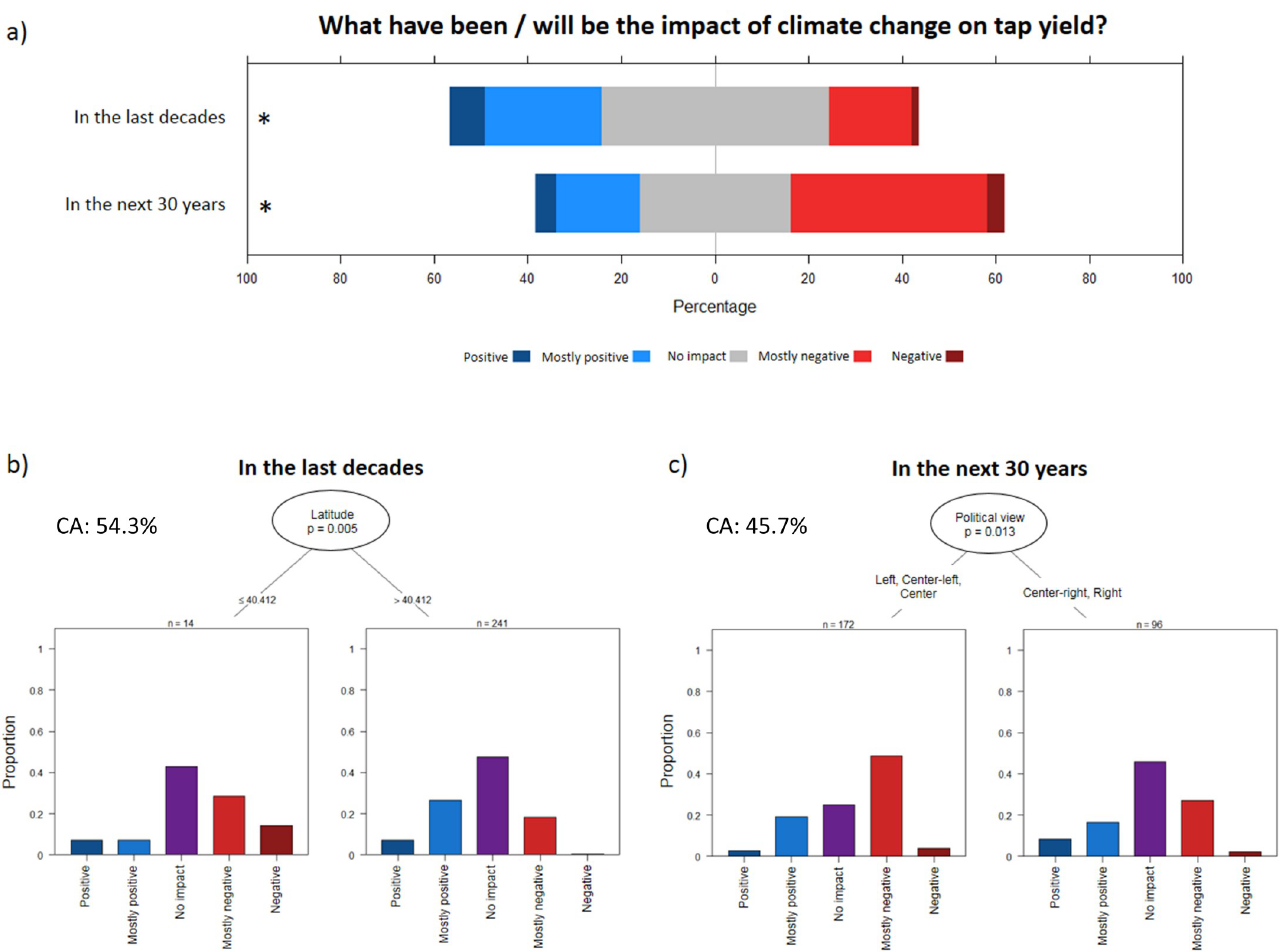
Fig 6. Climate change and tap yield. a) Responses of the survey participants for the questions What have been/will be the impact of climate change on tap yield in the last decades and in the next 30 years ? b and c) Conditional inference classification trees predicting the responses. Only significant predictors at p < 0.05 were retained by the algorithm. Sample size used to build the tree can be calculated by adding sample sizes indicated at each terminal node. CA value are the classification